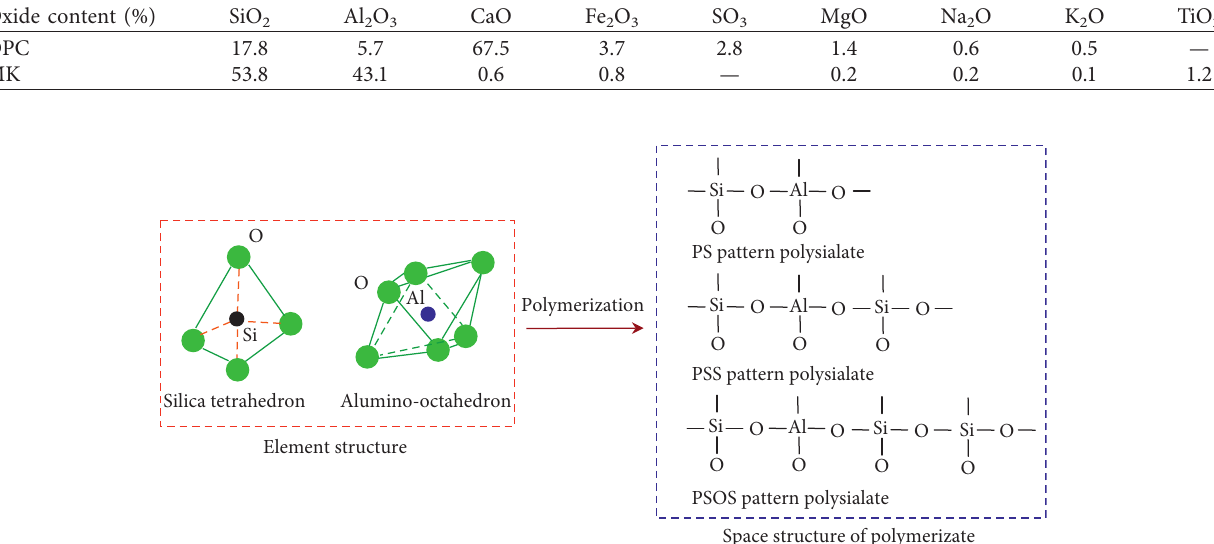
Figure 1: Formation of high-performance geopolymer